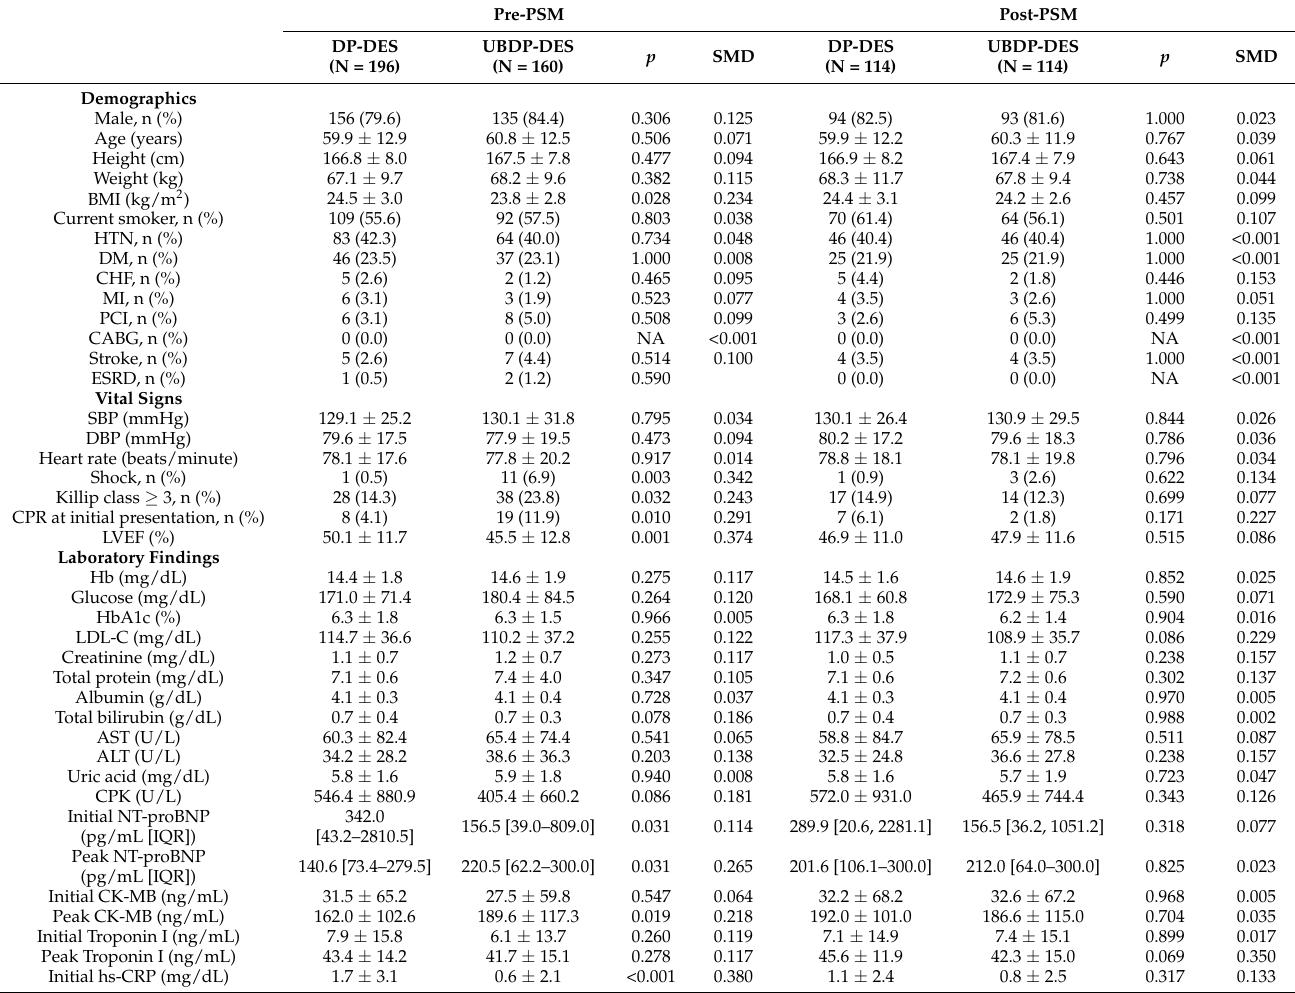
Table 1. Baseline demographic, vital signs, and laboratory findings pre- and post-propensity score matching (PSM). Pre-PSM